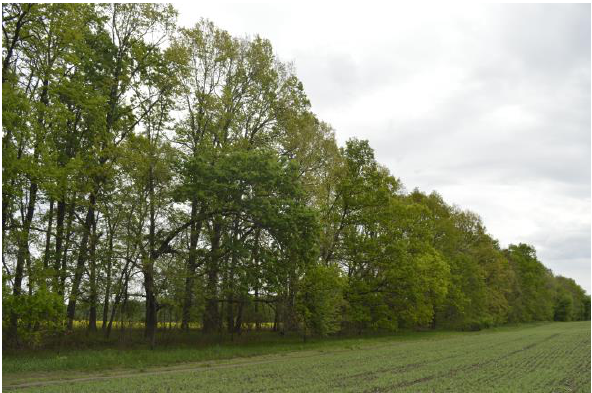
Fig. 7. Sambuco nigrae-Quercetum